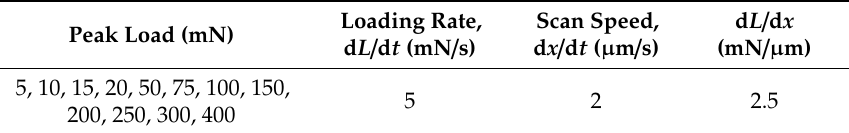
Table 2. Nano-scratch tests parameters.